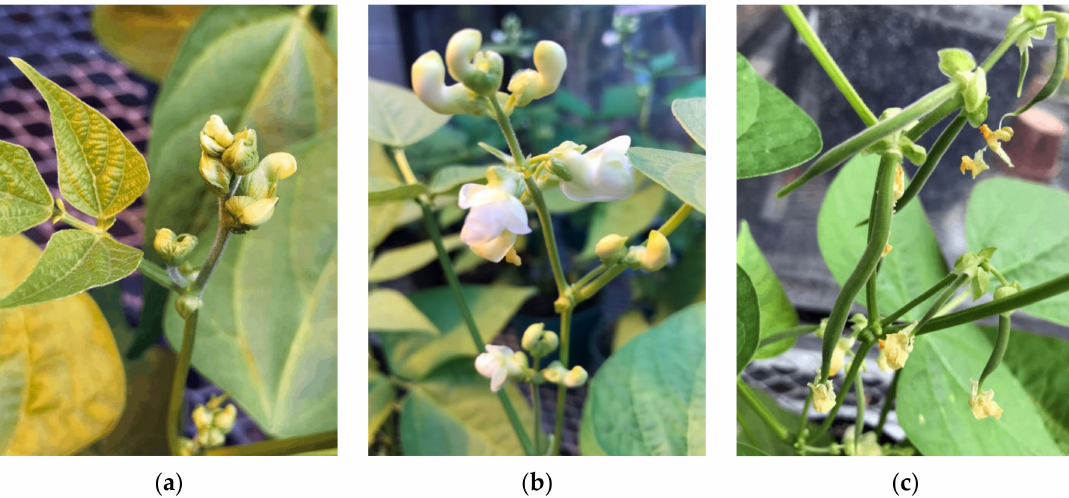
Figure 2. Three important stages of growth in snap bean: ( a ) budding, ( b ) flowering, and ( c ) pod